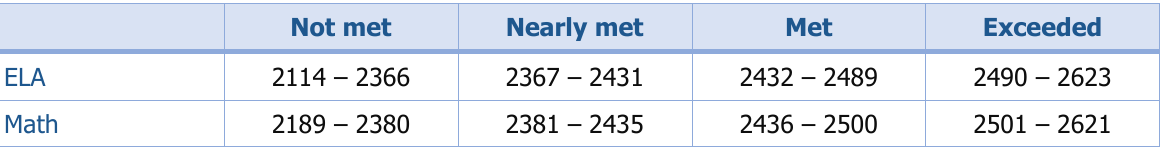
Table 1. SBAC Score Ranges per Descriptive Category for Third Grade Not